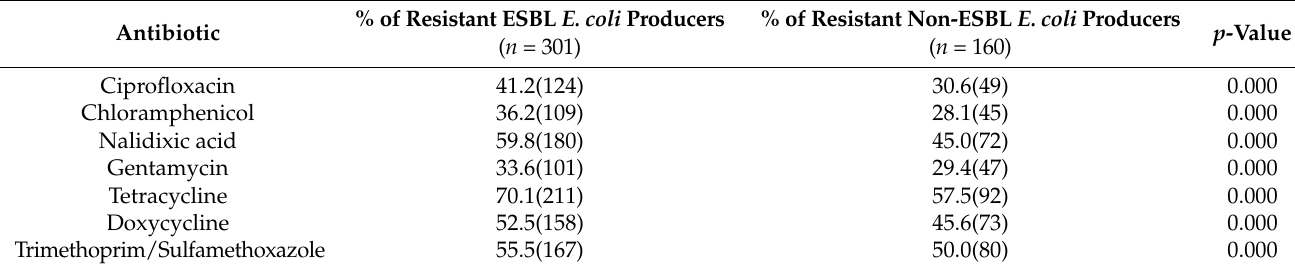
Table 6. Comparative antibiotic resistance of extended-spectrum beta lactamase (ESBL)- and non-ESBL-producing E. coli in cloacal and rectal swabs of poultry and domestic